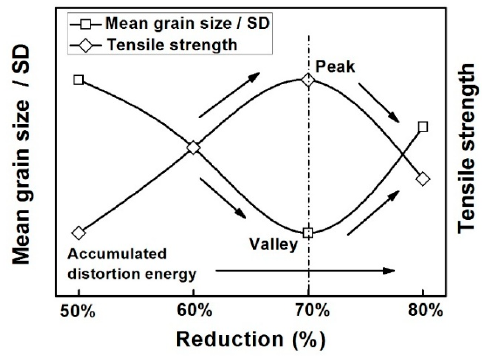
Figure 12. Schematic diagram of the relationship between reduction and mean grain size, SD, and tensile strength.